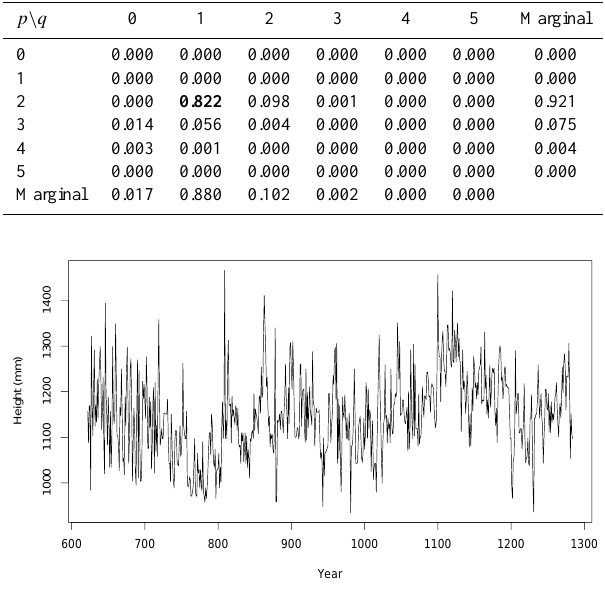
Figure 10. Annual Nile minima time series.